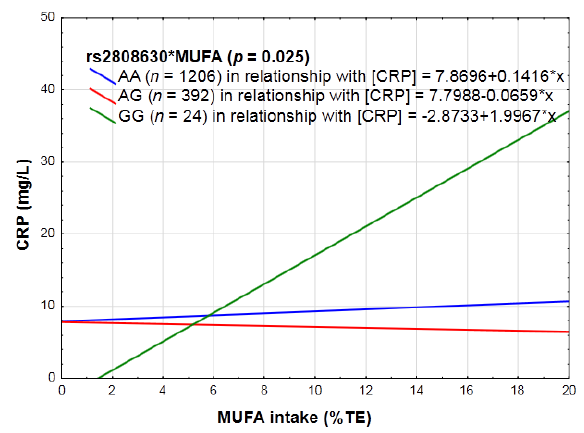
Figure 5. The linear relationship between monounsaturated fatty acids (MUFA) intake in relation to CRP concentrations categorized for rs2808630.